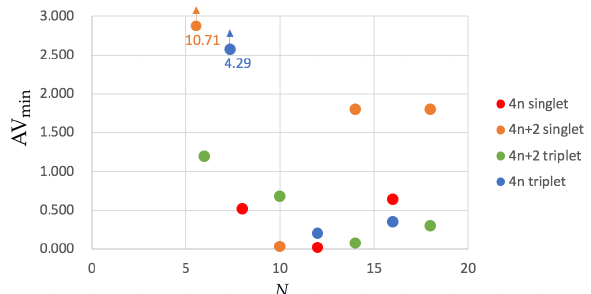
Figure 4. Values of AV min for the annulenes series (lowest-lying singlets and triplets) in terms of the number of C atoms ( N ). The species have been divided according to the number of electrons (4 n and 4 n + 2) and the spin multiplicity (singlet and triplet). Calculations were performed with